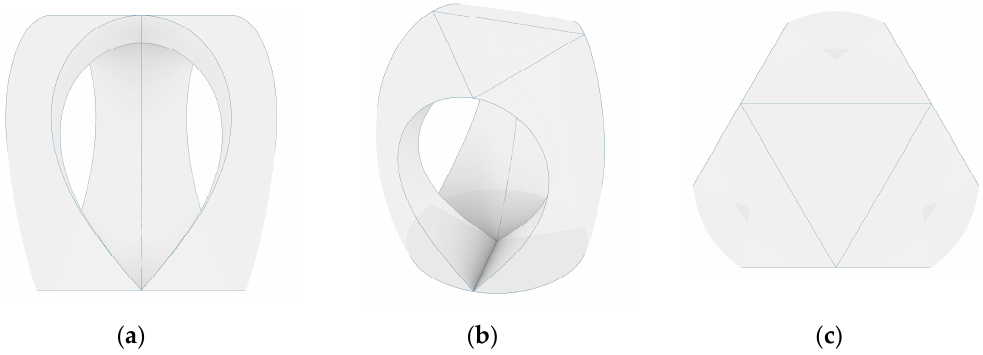
Figure 5. Digital model of a stool with three legs in a front view ( a ), perspective ( b ) and top view ( c )